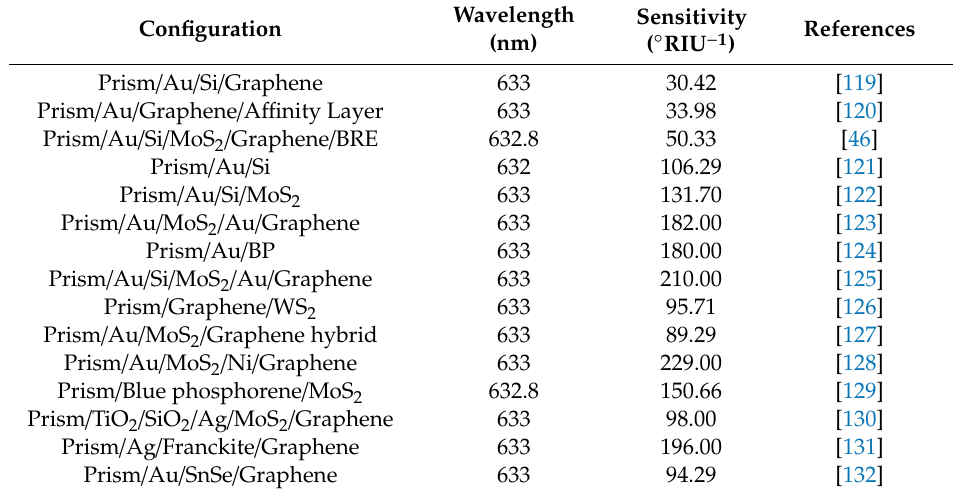
Table 6. Comparison of the sensitivity of the di ff erently reported SPR sensors based on 2D material.